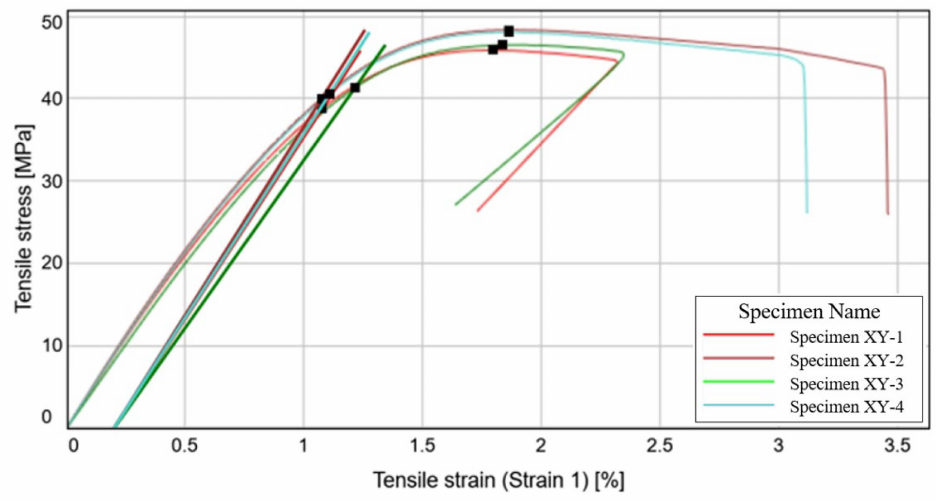
Figure 13. Stress-Strain curve variation for the XY